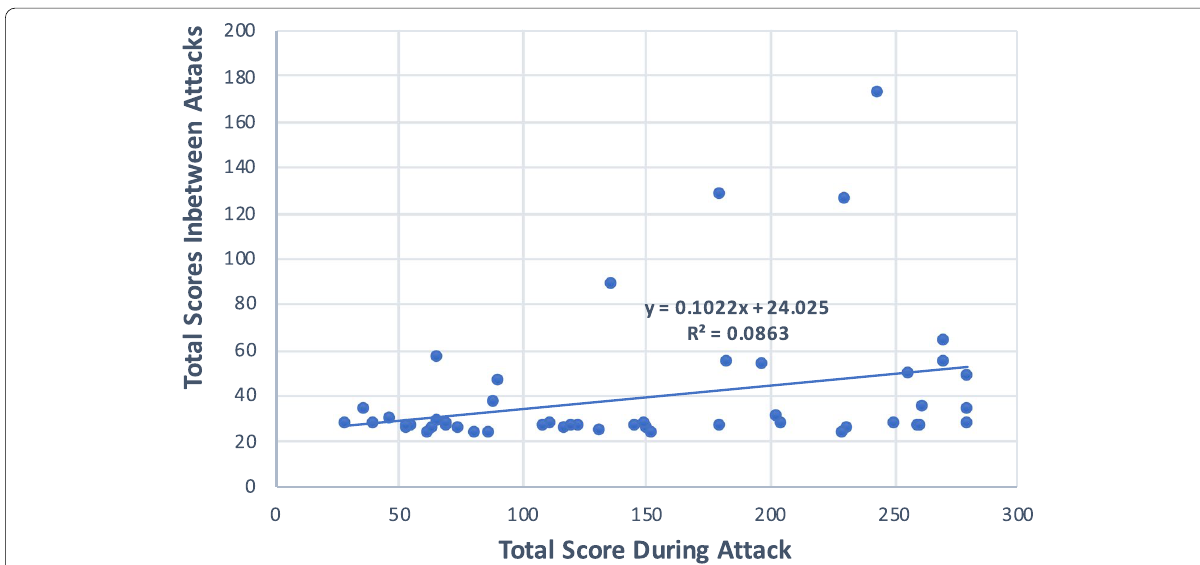
Fig. 1 Correlation between VADL scores during the attacks and in between the attack. VADL, Vestibular Disorder Activities of Daily Living Scale